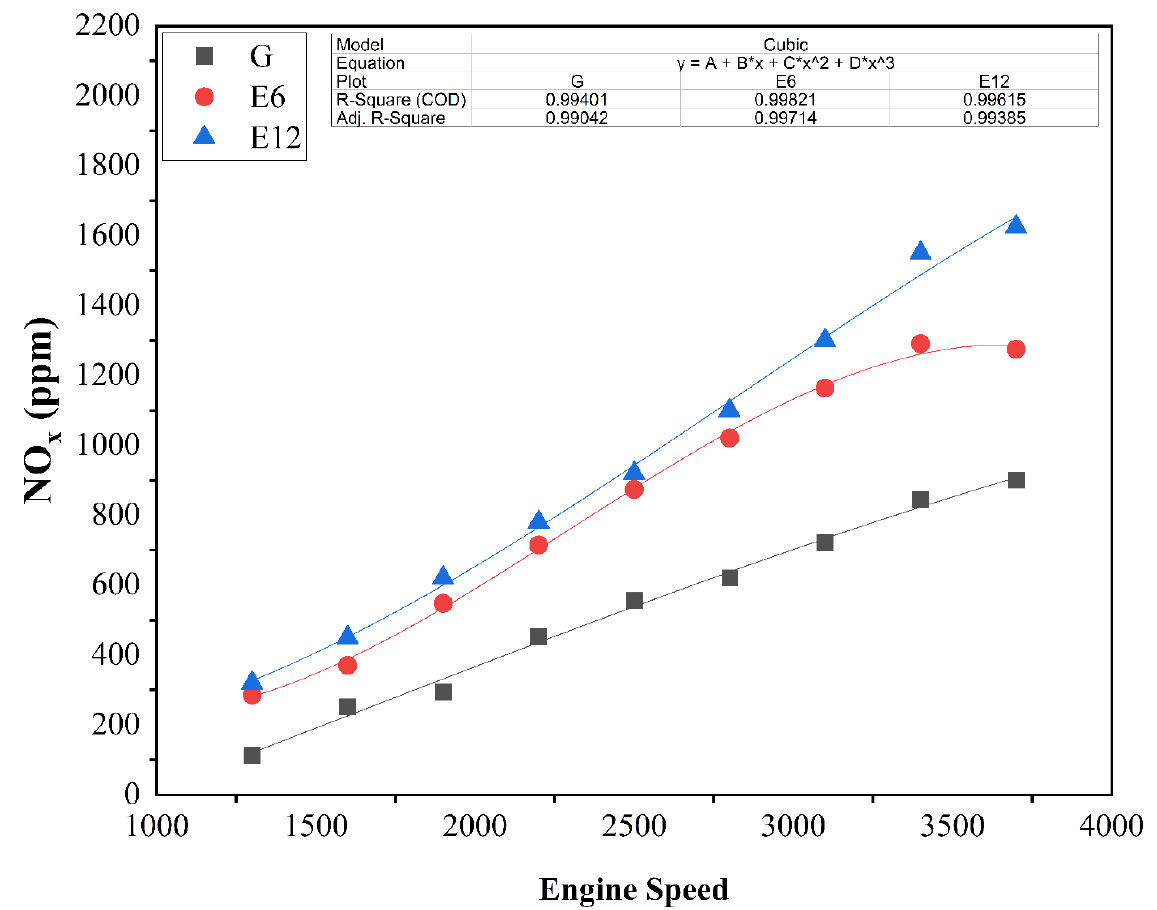
Figure 9. NO X variations with engine speed.